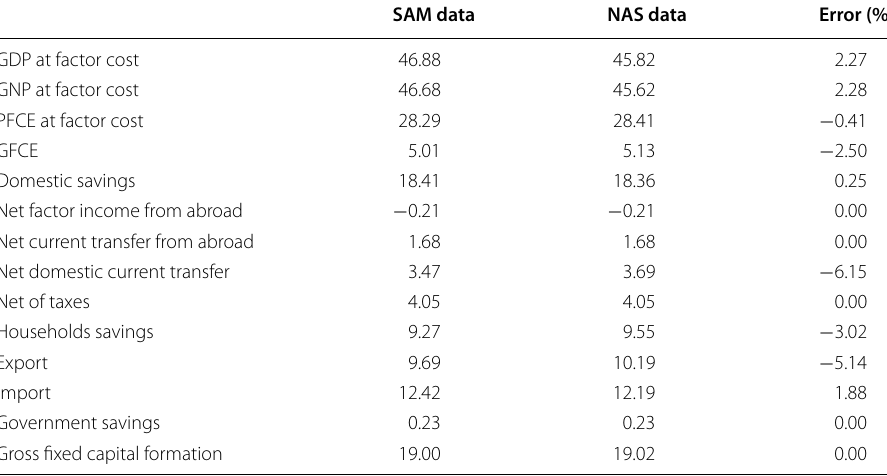
Table 5 Key macroeconomic aggregates from SAM and NAS data (trillion rupees)